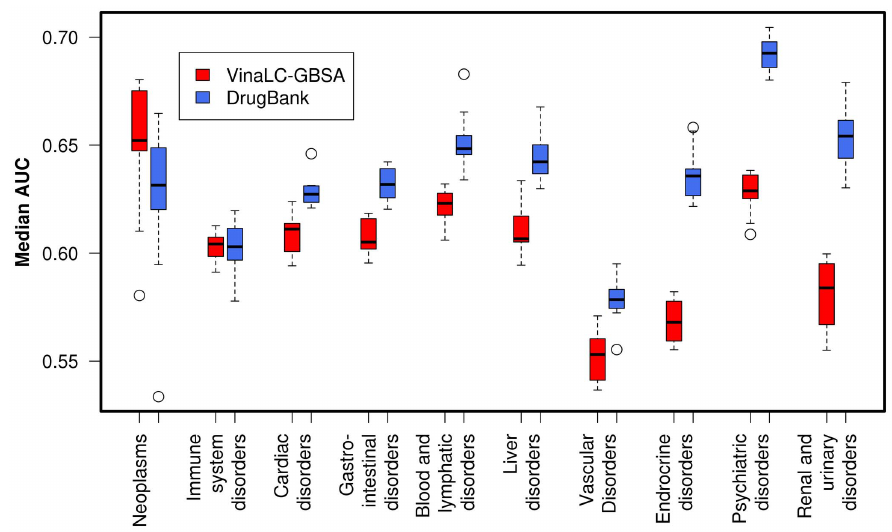
Figure 3. ADR prediction using a 16-protein virtual toxicity screening panel suggested by Bowes etal. [6]. Red boxes indicate models trained on GBSA-corrected VinaLC docking scores while the blue boxes indicate models trained on DrugBank drug-target protein associations. The boxplots comprise the distribution of median AUC scores after one vs. all L1-regularized logistic regression model training using 10-fold cross- validation repeated ten times. The individual models were trained on ten different adverse drug reaction (ADR) groups: Neoplasms, benign, malignant, and unspecified ("Neoplasms"), Immune system disorders ("Immune system disorders"), Cardiac disorders ("Cardiac disorders"), Gastrointestinal disorders ("Gastrointestinal disorders"), Blood and lymphatic systems disorders ("Blood and lymphatic disorders"), Hepatobiliary disorders ("Liver disorders"), Vascular disorders ("Vascular disorders"), Endocrine disorders ("Endocrine disorders"), Psychiatric disorders ("Psychiatric disorders"), and Renal disorders ("Renal & urinary disorders").